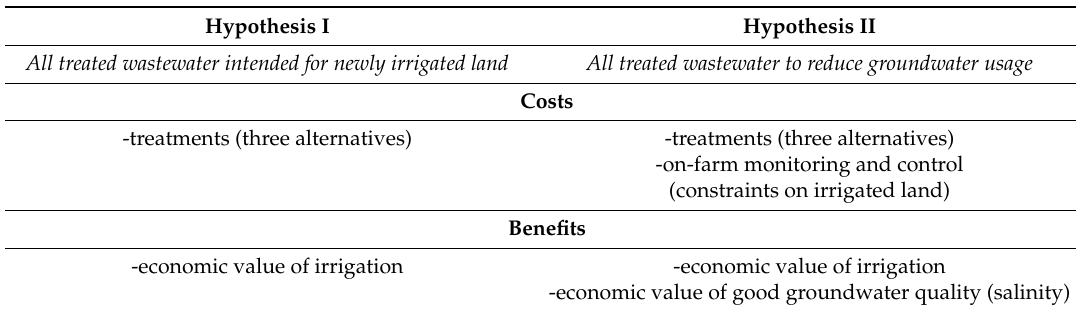
Table 1. Cost-benefit analysis framework.